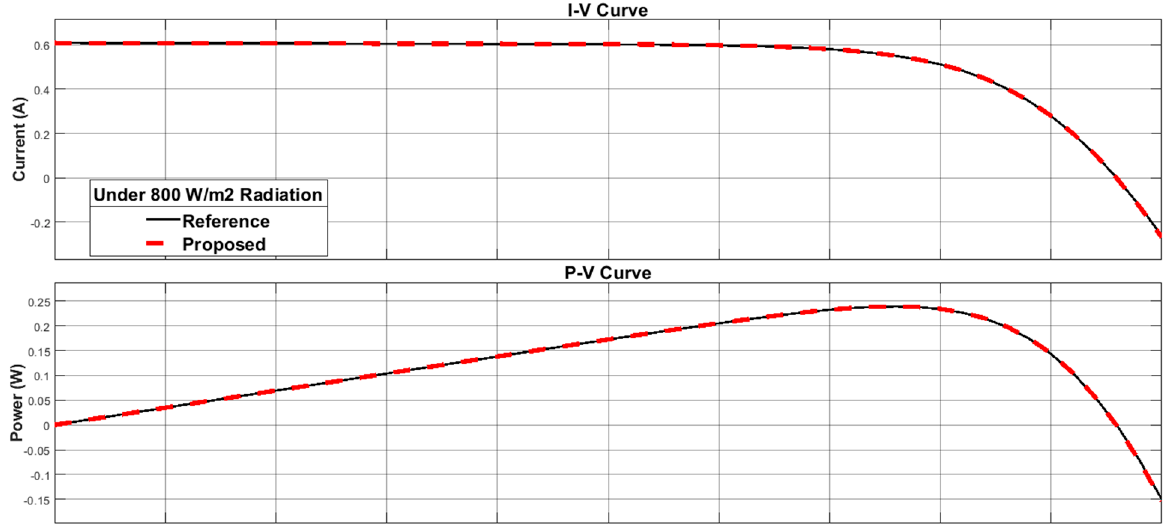
Figure 11. I − V and P − V curves for the reference and the proposed model under 800 W/m 2 radiation.